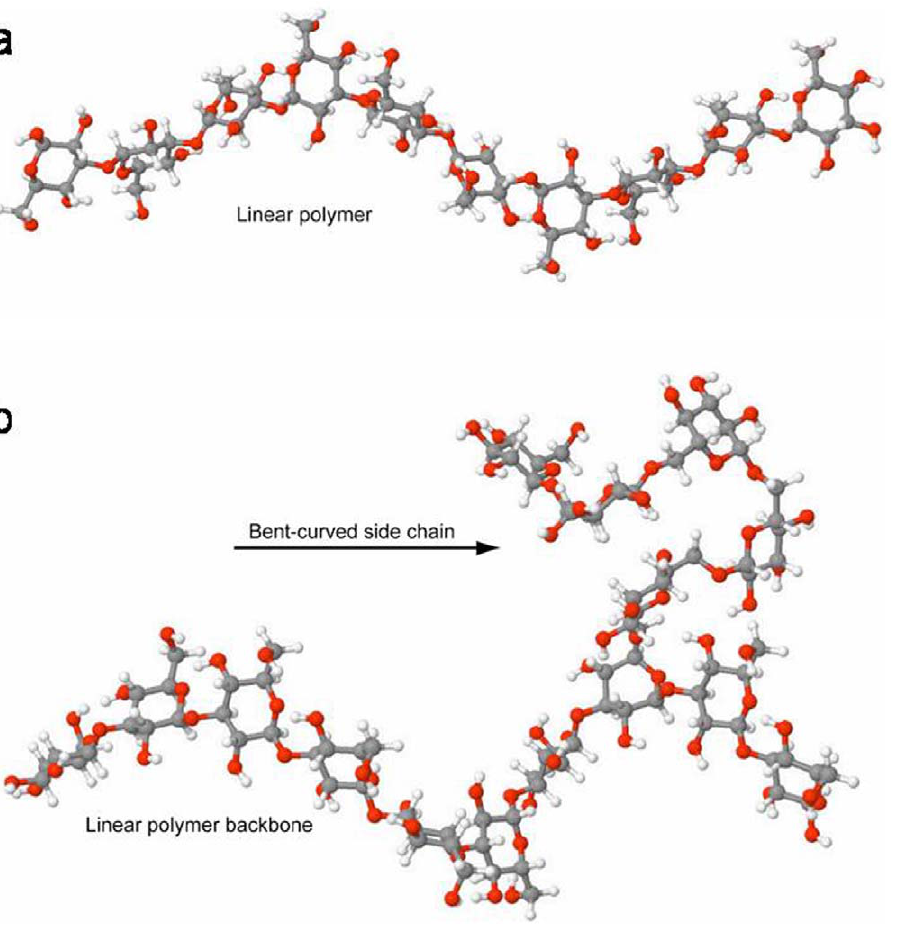
Figure 7. Molecular modeling suggests one possible conformation that (1 R 6)- b -linked glucan side chains may exhibit, that is, a hook-like, bent structure. Structure A (top) is a linear polymer containing ten (1 R 3)- b -linked repeat units in the polymer chain. The linear (1 R 3)- b -linked glucan backbone structure assumes an open helical conformation. Structure B (bottom) is the same linear structure except a side chain branches from the third repeat unit. The side chain contains five (1 R 6)- b -linked repeat units. The curvature and hook-like structure of the side chain is evident in this model where the structure has been rotated slightly to optimize visualization of the curved side chain. The structures are rendered using JMOL